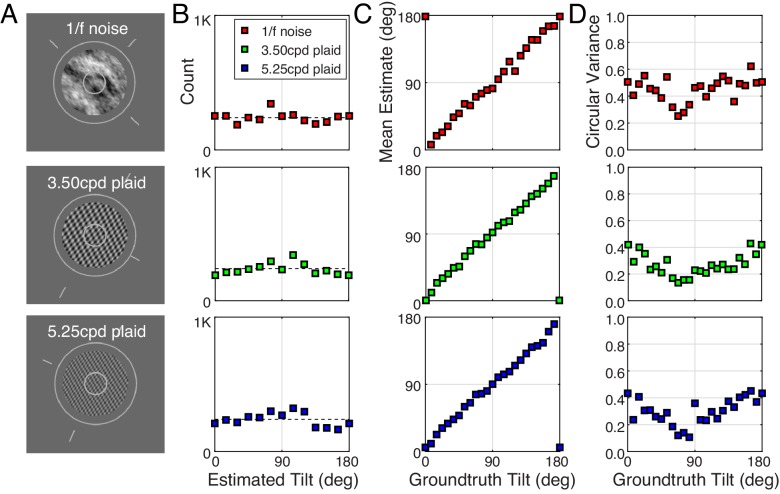
Summary statistics for the three different artificial stimulus types: 1/f noise, 3.50 cpd plaid, 5.25 cpd plaid (top, middle, and bottom rows, respectively).Estimate variance for 1/f noise texture artificial stimuli is slightly higher than estimate variance with the plaids. The patterns are otherwise similar.